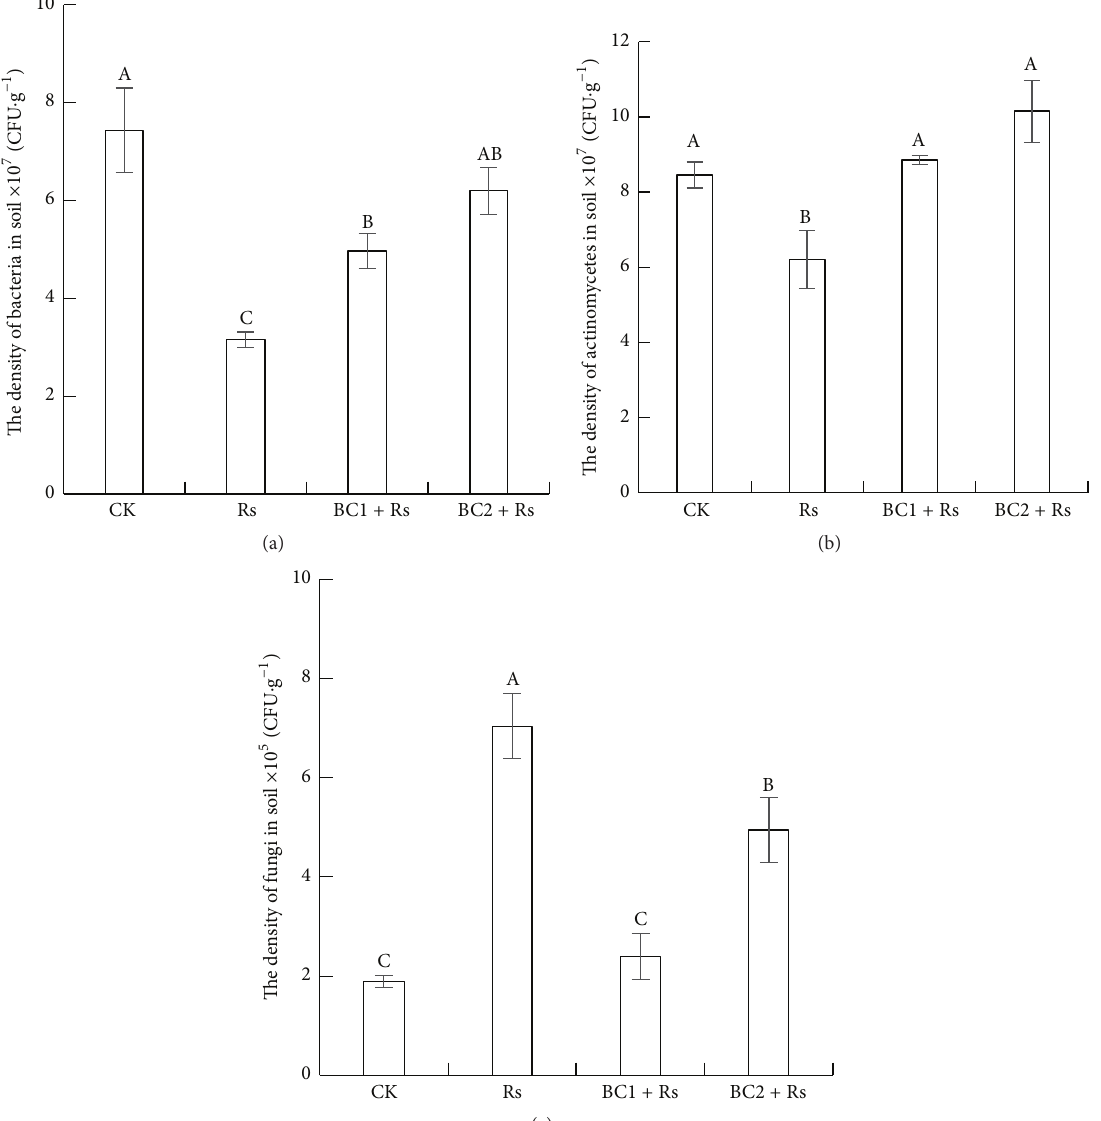
Figure 4: Effects of biochar amendment and R. solanacearum on the amount of soil bacteria (a), actinomycetes (b), and fungi (c). CK, no biochar and no R. solanacearum inoculation; Rs, R. solanacearum inoculation; BC1 + Rs, peanut biochar amendment and R. solanacearum inoculation; BC2 + Rs, wheat biochar (BC2) amendment and R. solanacearum inoculation. Different letters on the columns denote a significant difference at 𝑃 < 0.05 using the DMRT (Duncan’s new multiple range tests)